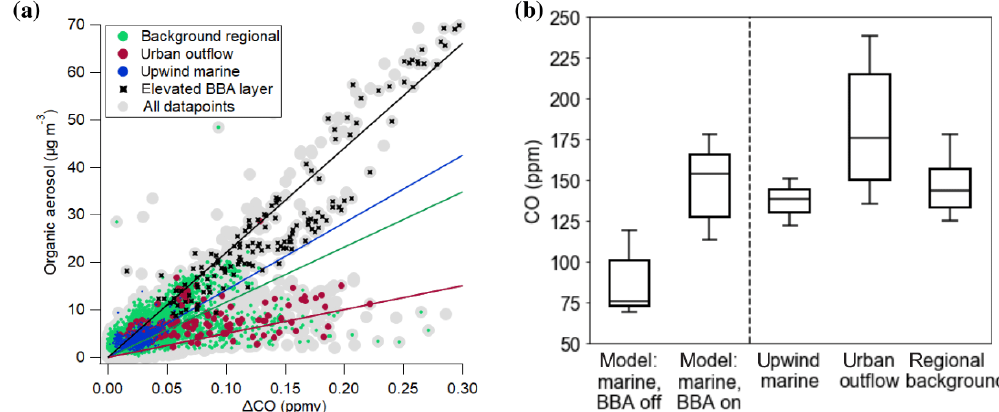
Figure 7. (a) The ratio of organic aerosol to CO, with lines of regression included for each of the three regimes and the elevated BBA layer between 2 and 4km. CO is shown as enhancement above the background (0.11/0.10ppmv for in/above the monsoon layer). (b) CO concentrations. Modelled results from GEOS-Chem show the CO concentration in the upwind marine regime with biomass burning emissions off/on. Observational results are shown from all three regimes. The model simulation is only comparable with observational measurements when biomass burning is considered.